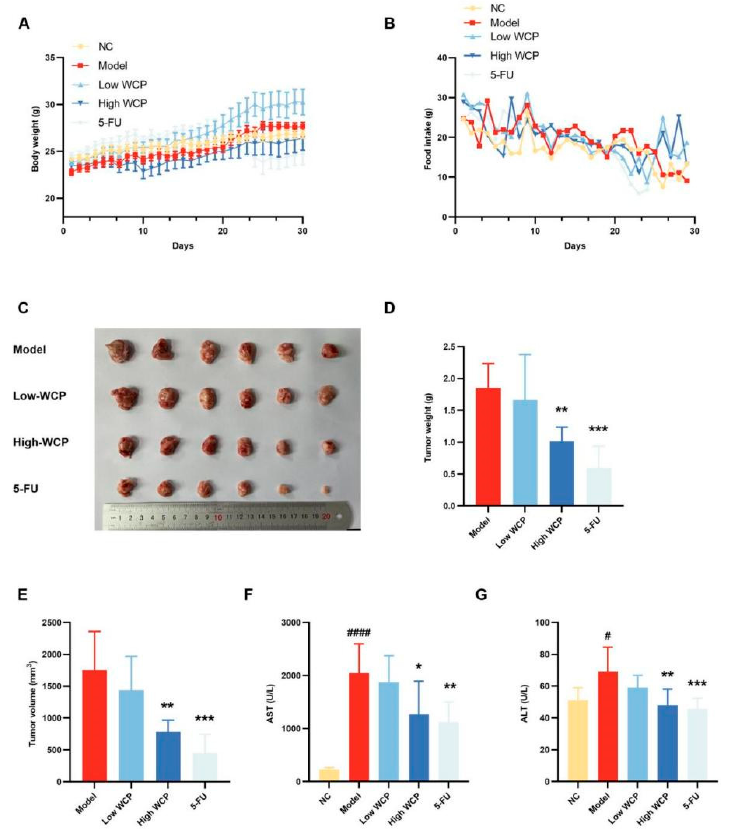
Figure 3. WCP alleviated the symptoms of H22 tumor-bearing mice. ( A , B ) Effects of WCP on the body weight and food intake. ( C ) Photographs of tumors from each group. ( D , E ) Tumor weight and volume of tumors. ( F , G ) Effects of WCP on the levels of serum AST and ALT. # p < 0.05, #### p < 0.0001 compared to NC group; * p < 0.05, ** p < 0.01, *** p < 0.001 compared to model group.